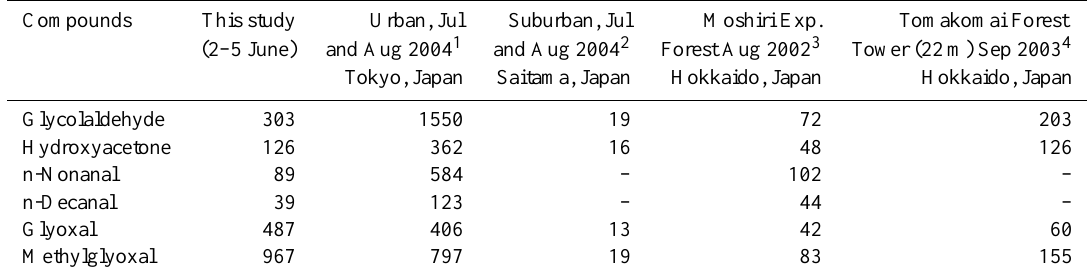
Table 4. Comparison of averaged carbonyl concentrations (ng m − 3 ) of this study with those reported in the urban, suburban and forest atmospheres.